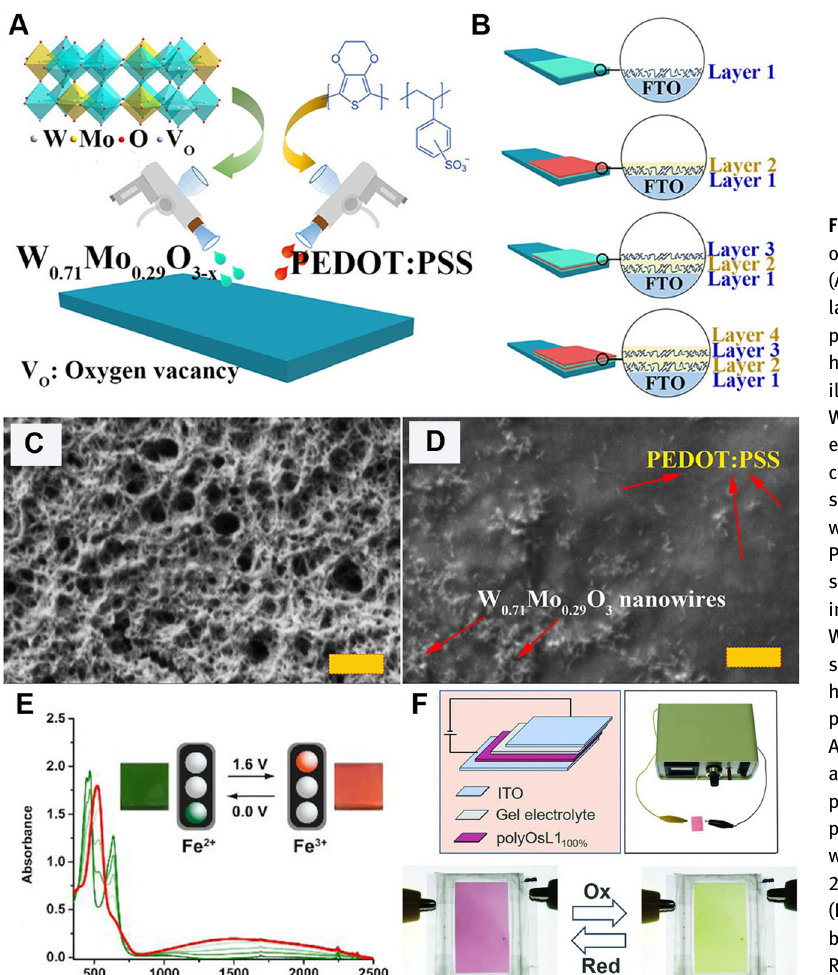
Figure 4: Preparation and characterization of organic-inorganic hybrid films. (A) Schematic illustration of the spray layer-by-layer assembly process used to prepare the W 0.71 Mo 0.29 O 3 /PEDOT:PSS hybrid electrochromic fi lms. (B) Schematic illustration of the evolution of the W 0.71 Mo 0.29 O 3 /PEDOT:PSS hybrid electrochromic fi lms during the initial four cycles. Layers 1 and 3 depict the porous structure of W 0.71 Mo 0.29 O 3 material, whereas Layers 2 and 4 depict the PEDOT:PSS material. (C) Field emission scanning electron microscope (FESEM) image of the spray-coated pure W 0.71 Mo 0.29 O 3 fi lms(D)FESEMimageofthe spray-coated W 0.71 Mo 0.29 O 3 /PEDOT:PSS hybrid fi lms (A – D) Reproduced with permission from Ref. [92]. Copyright 2018, American Chemical Society. (E) Optical absorbance of FeL2-MEPEs at different potentials with the corresponding photographs of the thin fi lms. Reproduced with permission from Ref. [104]. Copyright 2017, American Chemical Society. (F) Schematic illustration of linear Os II ‐ based MEPEs electrochromic device. Reproduced with permission from Ref. [105]. Copyright 2018,